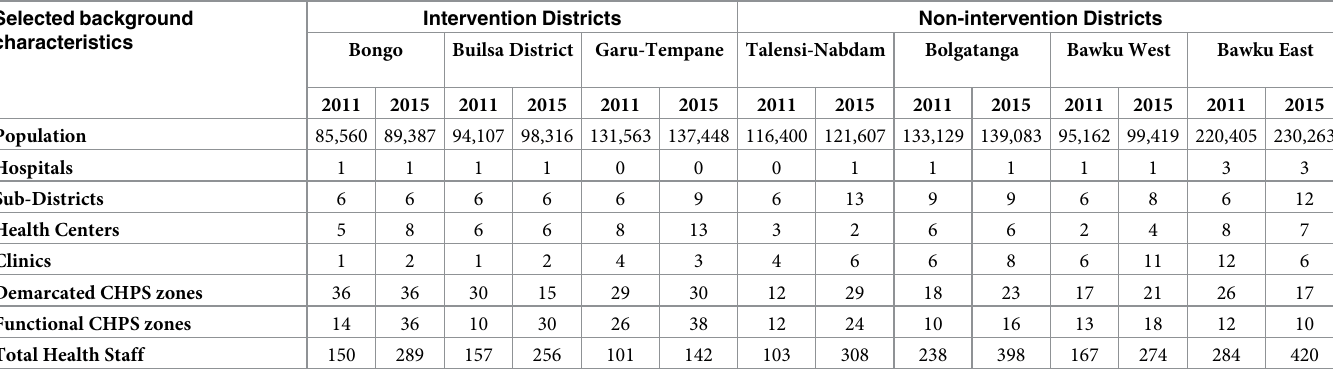
Table 2. Background characteristics of study districts.